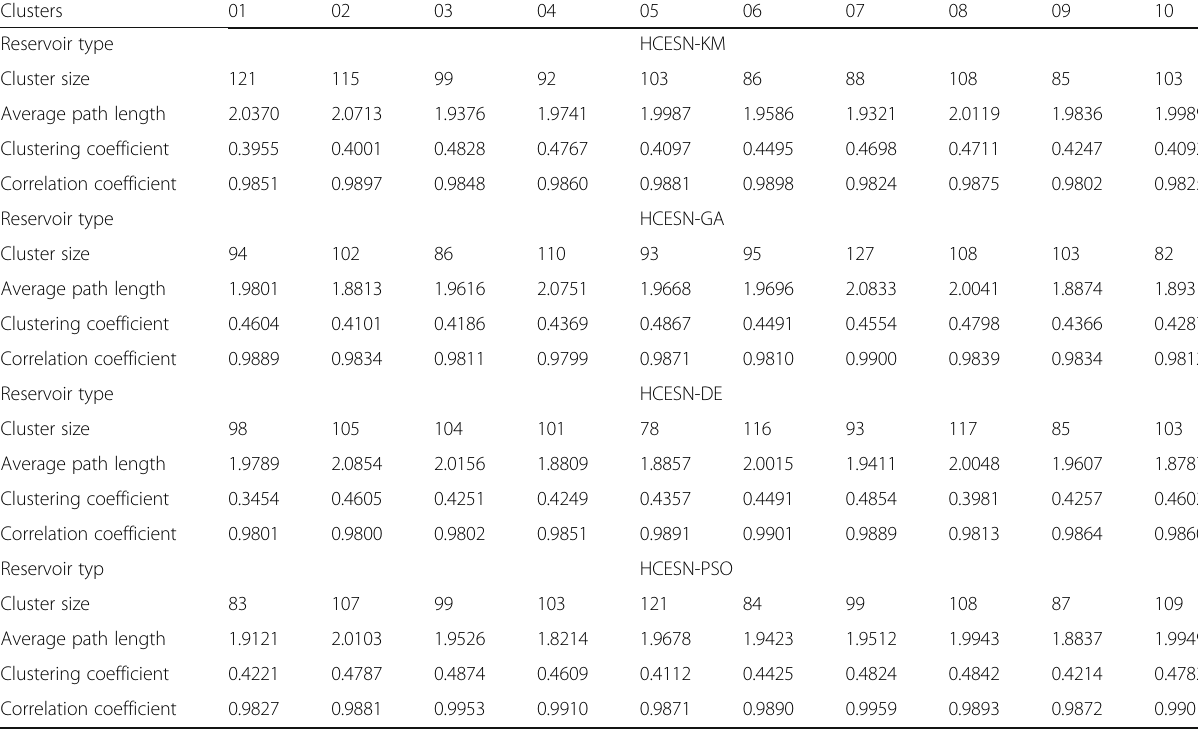
Table 2 The characteristics of the scale-free and small-world for ten clusters